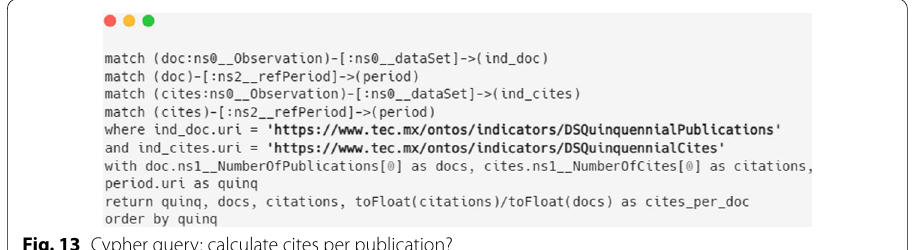
Fig. 13 Cypher query: calculate cites per publication?